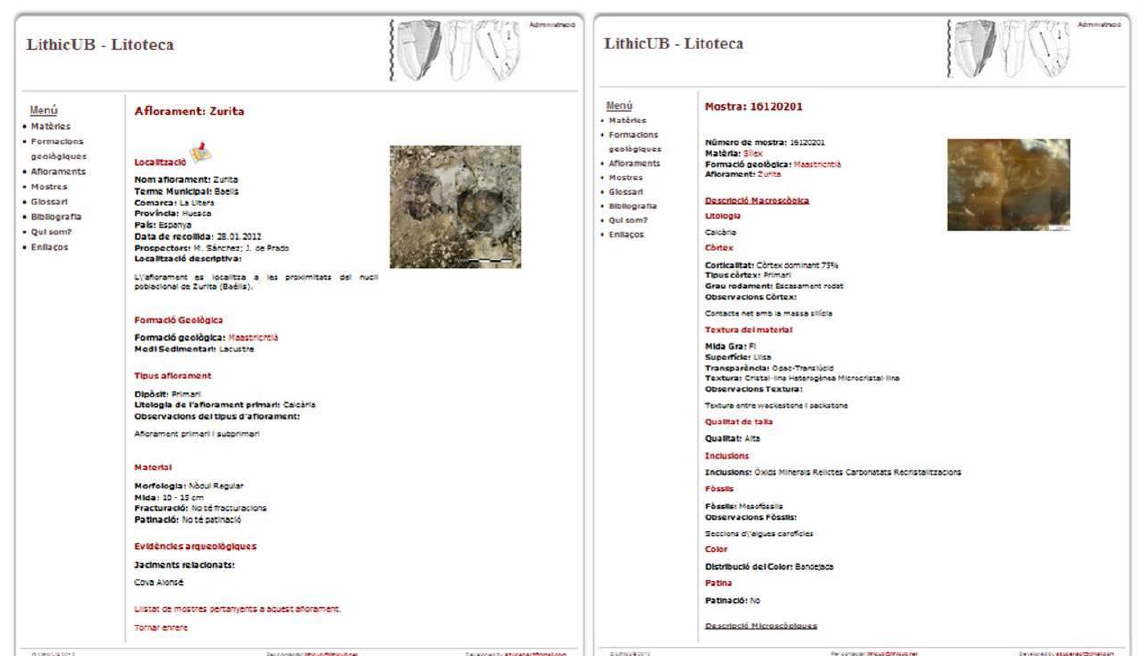
Figure 2. Outcrop description and macroscopic description that can be consulted on our web